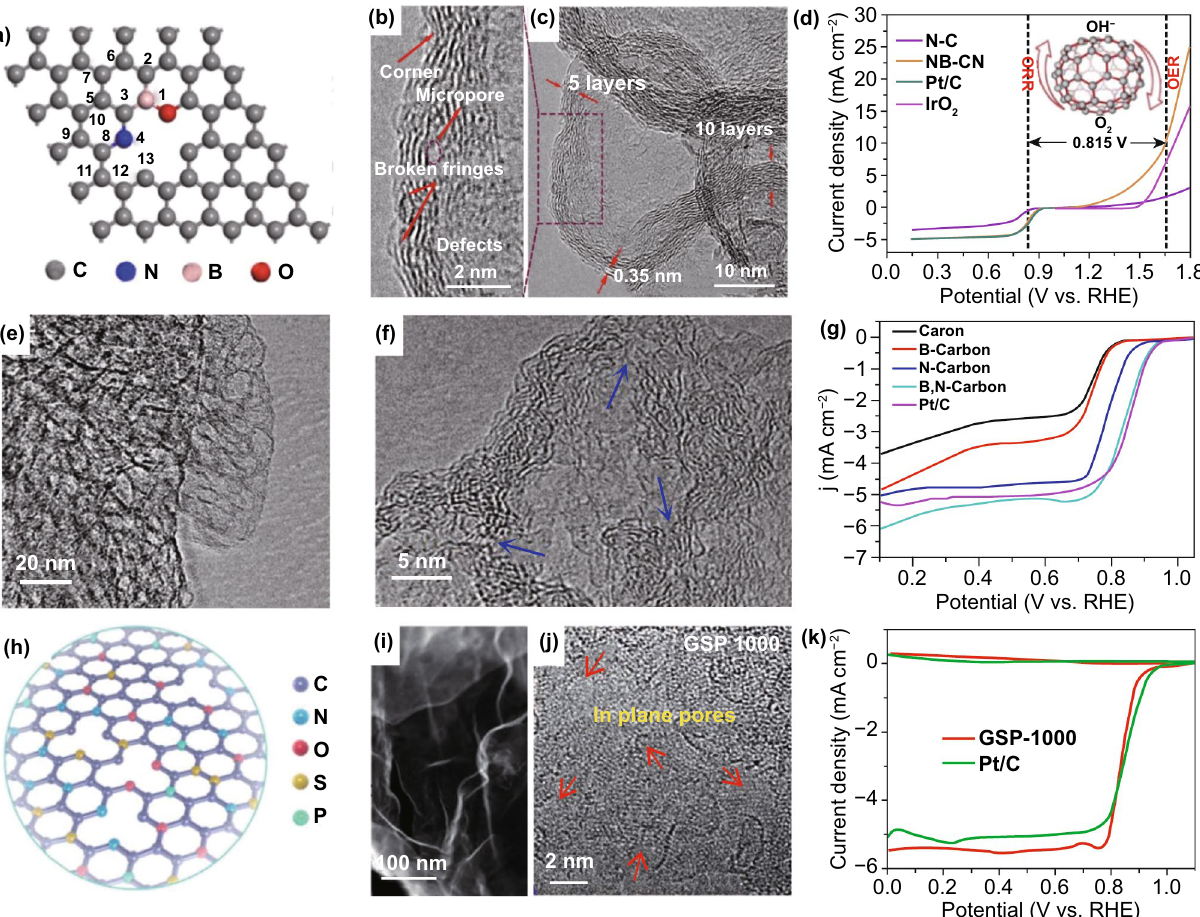
Fig. 9 Defects coupled with multiple dopants in nanocarbon for ORR. a Schematic illustration of B-/N-codoped defective nanocarbon; b , c TEM images of B-/N-codoped carbon with various defective sites; d ORR and OER performance of NB-CN. Reproduced with permission from Ref. [143]. Copyright 2017, Elsevier. e, f TEM images of B-/N-codoped carbon hollow nanocages; g ORR activity of various samples. Repro- duced with permission from Ref. [144]. Copyright 2018, Wiley–VCH. h Schematic illustration of multiple heteroatom-doped (N/S/P/O) nano- carbon; i , j TEM images of N/O/S/P-doped carbon containing a large number of in-plane pore defects; k RRDE measurements of GSP-1000 and Pt/C catalysts. Reproduced with permission from Ref. [147]. Copyright 2018, The Royal Society of